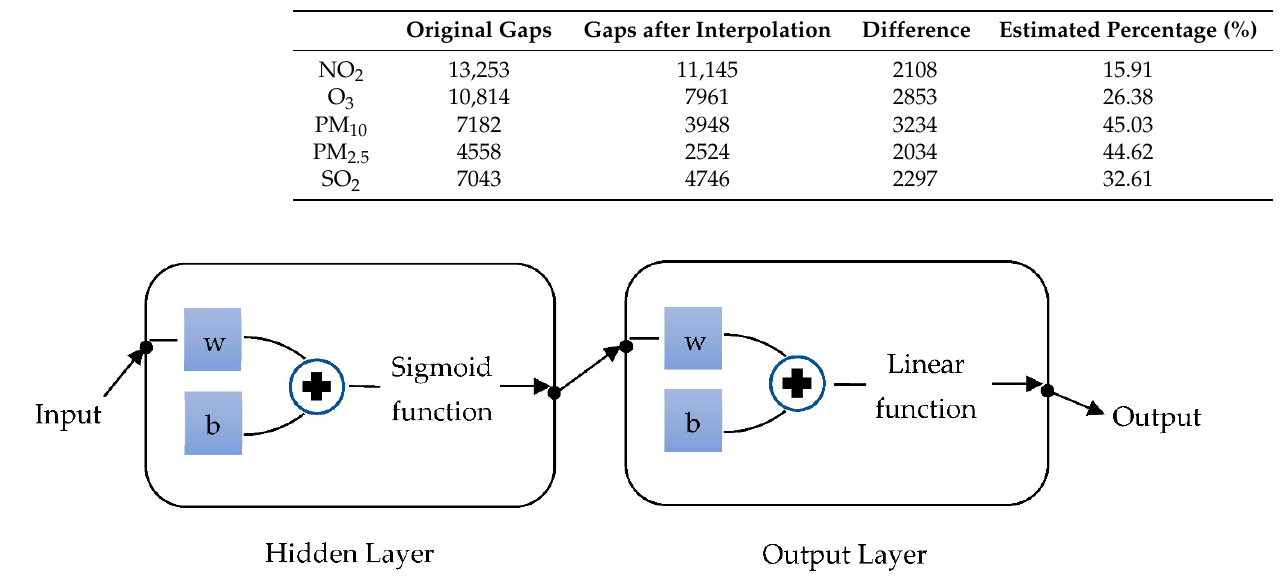
Figure 2. A two-layer network with sigmoid hidden neurons and linear output neurons.